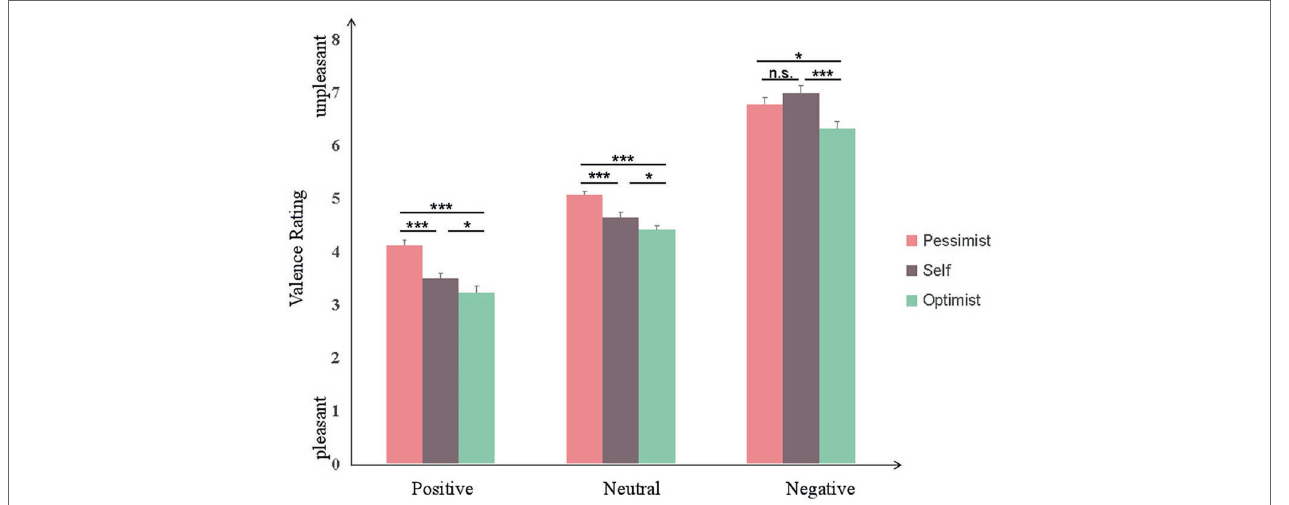
FIGURE 2 | Valence ratings for 36 participants after taking each of the three perspectives. Error bars represent SEM, n.s. means “not significant,” * p < 0.05; *** p < 0.001.